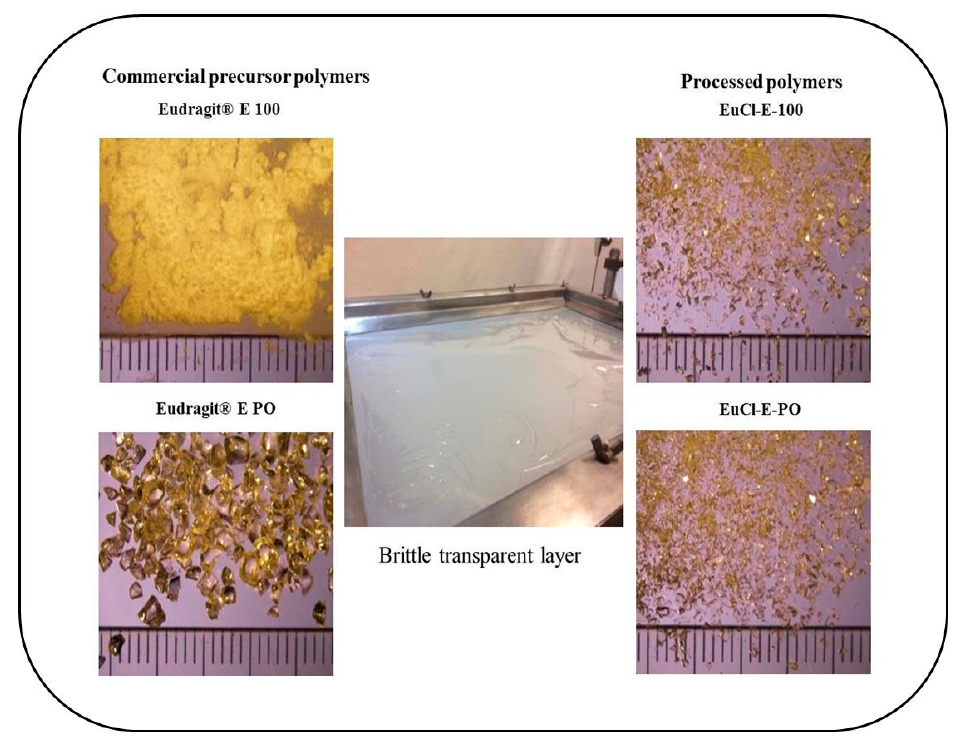
Figure 6. Micrograph images of polymers derived from Eudragit ® E.